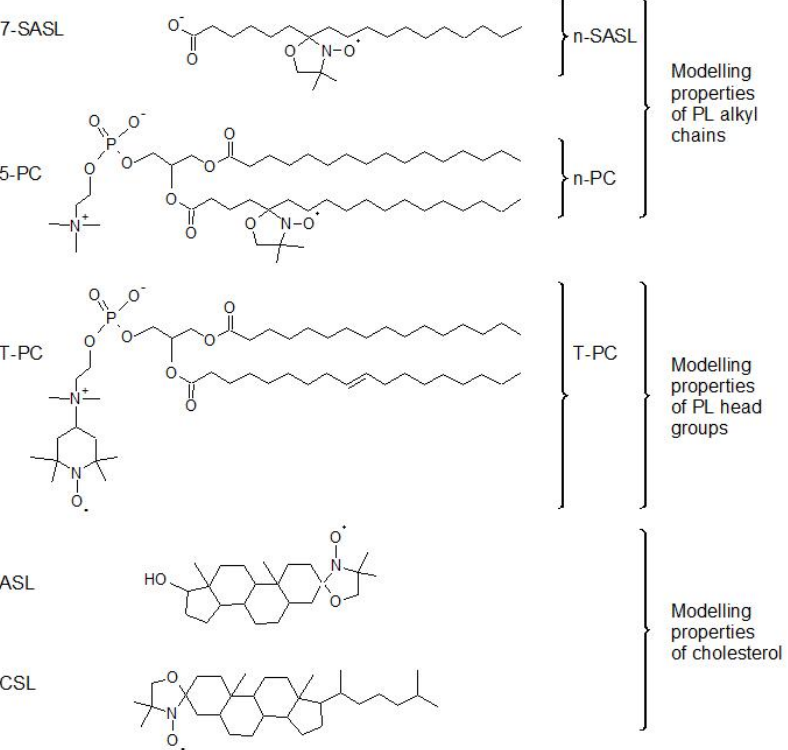
Figure 1. Chemical structures of three classes of lipid spin labels used in membrane studies. Stearic acid spin labels ( n -SASL—n-doxylstearic acid spin label); PL spin labels (n-PC—1-palmitoyl-2-(n- doxylstearoyl)phosphatidylcholine and T-PC—tempocholine-1-palmitoyl-2-oleoylphosphatidic acid ester); and Chol-analog spin labels (ASL—androstane spin label and CSL—cholestane spin label).